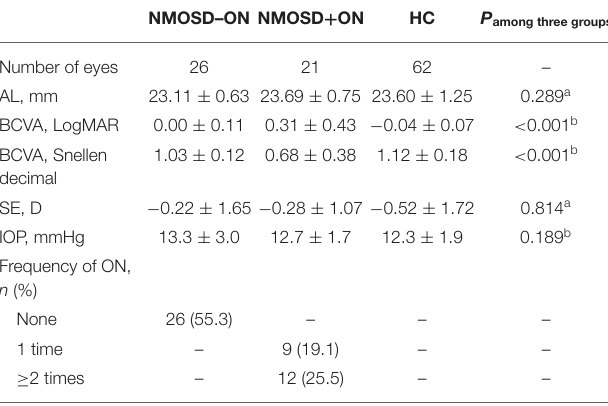
TABLE 2 | Basic ophthalmic assessments of NMOSD–ON, NMOSD + ON, and HCs. NMOSD–ON NMOSD + ON HC P